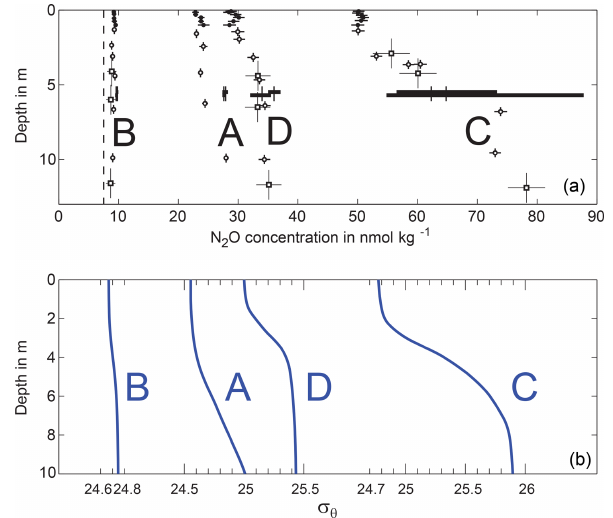
Figure 4. N 2 O and density profiles at the off-ship high-resolution stations A to D, complemented by shipboard observations at adja- cent positions and times. For positions and times of station A to D see Fig. 1. Distances to land – B: 106nm; A: 48nm; D: 36nm; C: 7nm. 95% limits of 10m wind distribution in meters per sec- ond (ms − 1 ): B [4.3 6.6], A [3.1 6.0], D [2.6 5.9], C [3.3 5.4]. (a) N 2 O measurements with 95% confidence limits from measure- ment uncertainty; black dots in top 1m: samples from centrifugal pump off-ship; black circles below 1m: samples from Niskin bottles off-ship; black squares: samples from shipboard CTD; thick black lines: 95% limits of distribution of continuous ship samples during approach and departure of the station, median values are marked. (b) Density profiles derived from MicroCat temperature and con- ductivity profiles at stations A to